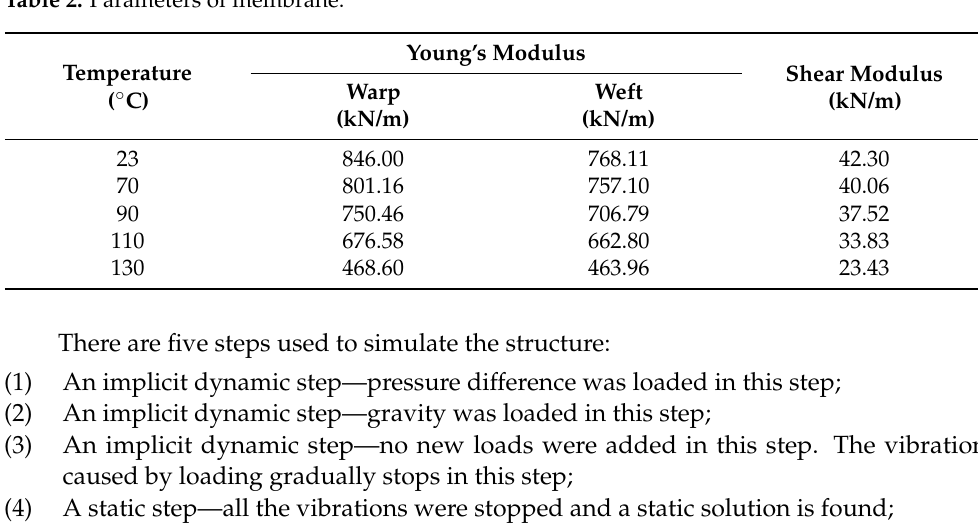
Table 2. Parameters of membrane.